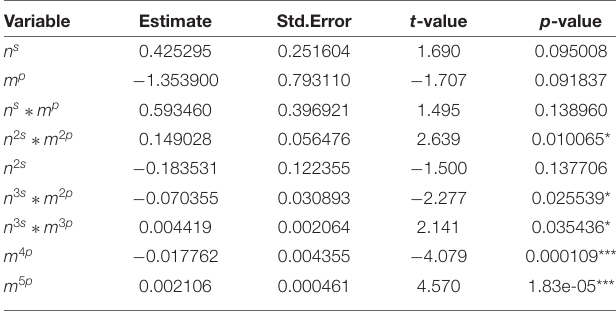
TABLE 5 | Summary statistics for selected variables in finite sample size between 91 and 120.